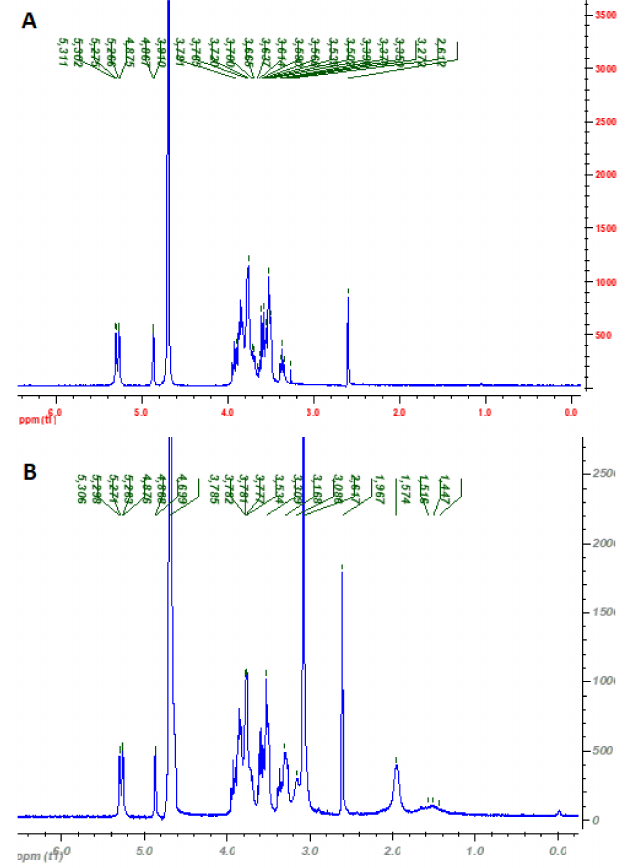
Figure 3. 1 H-NMR spectra of: ( A ) original pullulan (c = 2 mg / mL in D 2 O) measured at 25 ◦ C; and ( B ) cationic pullulan (C-PUL) (c = 2 mg / mL in D 2 O) measured at 25 ◦ C under the same instrumental